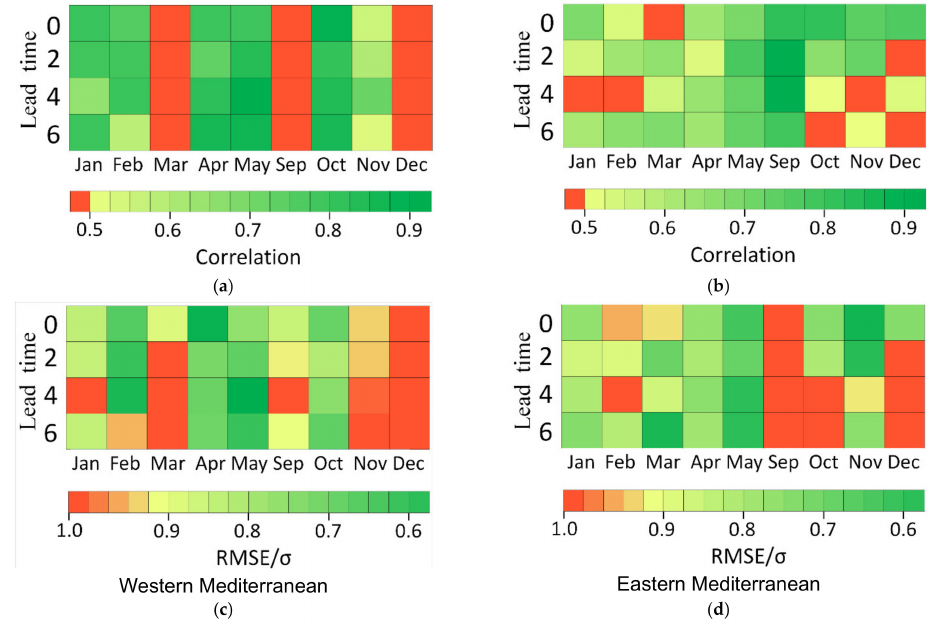
Figure 12. The diagrams of correlation ( a , b ) and RMSE/ σ ( c , d ) for lead times of 0, 2, 4, and 6 months between the modeled and original frequency of intense cyclones in the Western ( a , c ) and Eastern ( b , d ) Mediterranean. Correlation coefficient significant at α = 0.01 (for the number of degrees of freedom n = 11) is